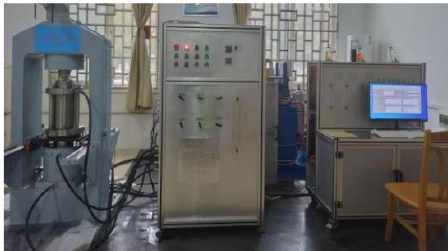
Figure 3. The automatic rock triaxial test system.